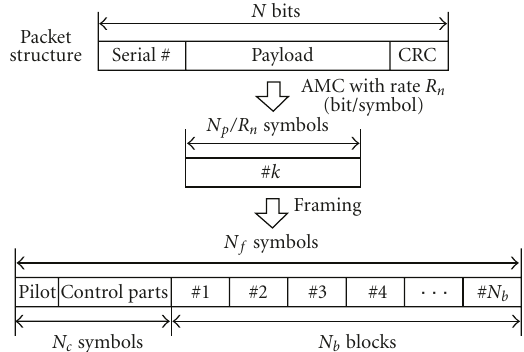
Figure 1: Packet and frame structures